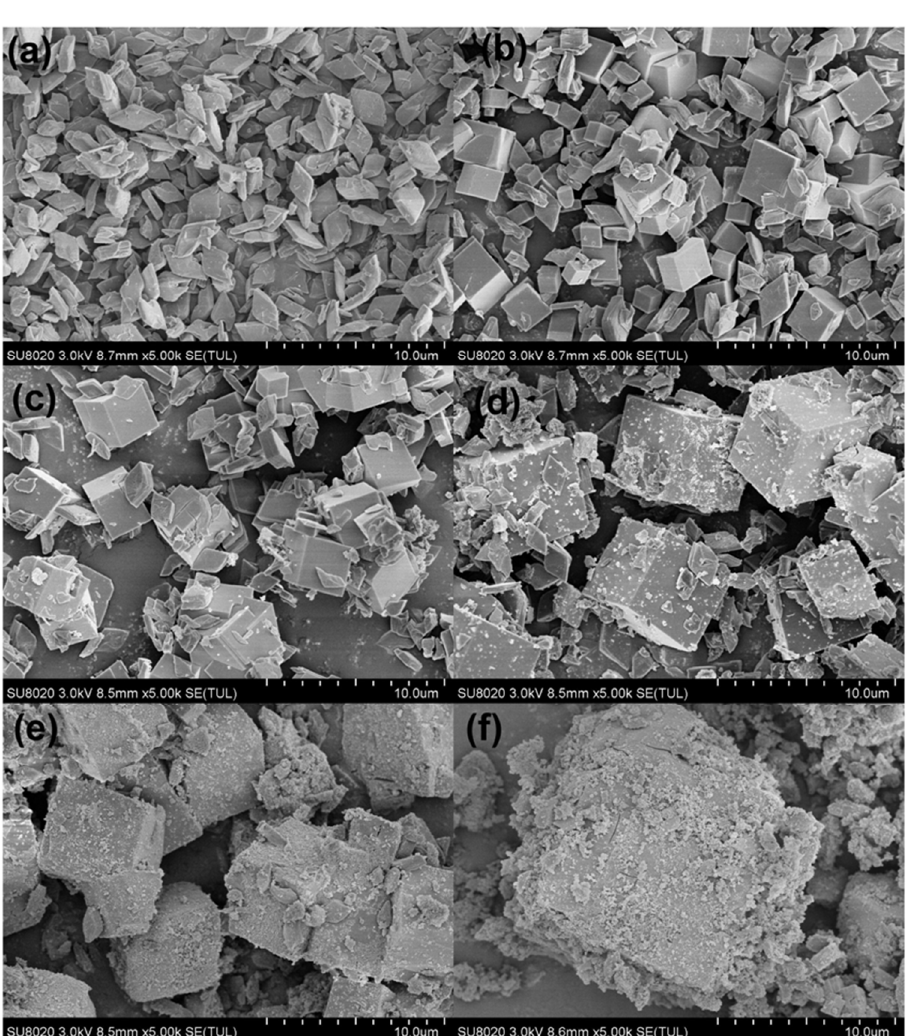
Figure 2. SEM images of as-synthesized samples: ( a ) SP-0.0; ( b ) SP-0.2; ( c ) SP-0.4; ( d ) SP-0.6; ( e ) SP-0.8; ( f ) SP-1.0.